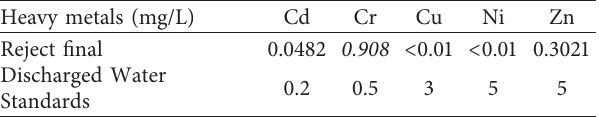
Table 6: Results of the metallic characterization.